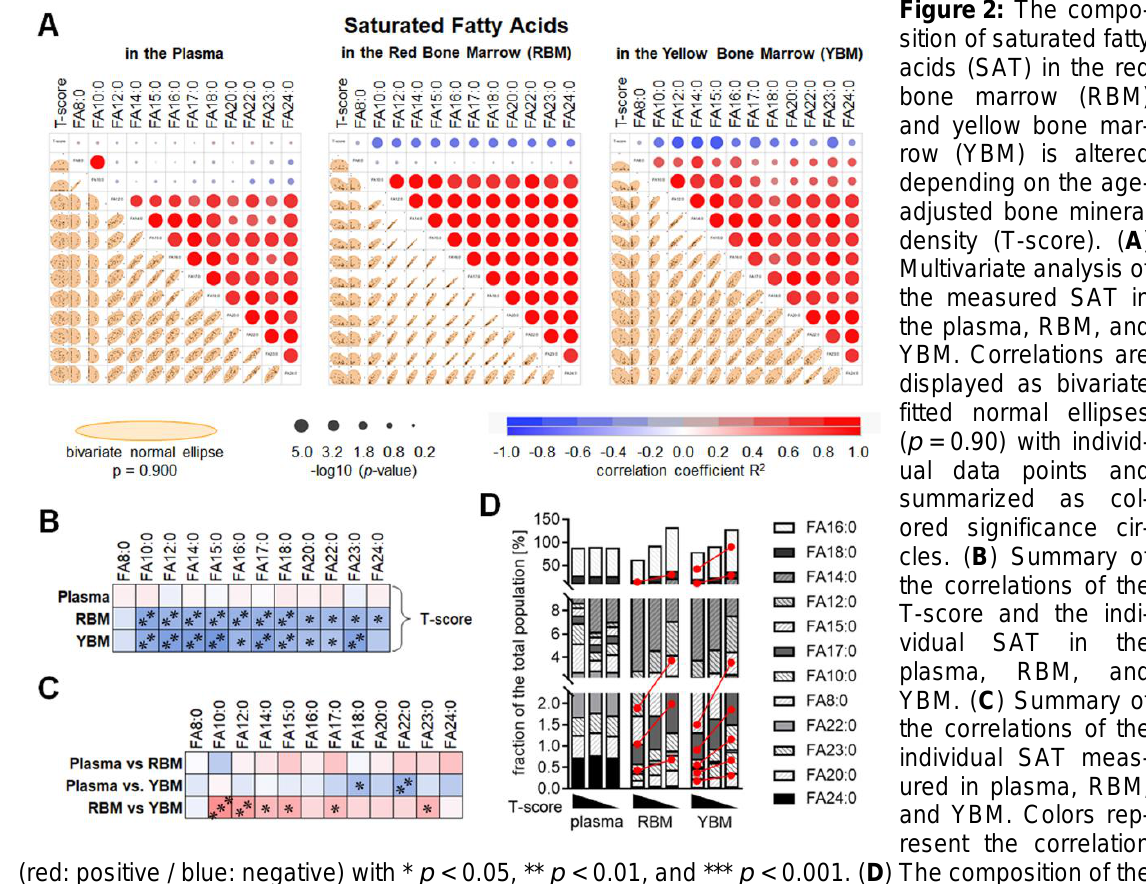
Figure 2: The compo- sition of saturated fatty acids (SAT) in the red bone marrow (RBM) and yellow bone mar- row (YBM) is altered depending on the age- adjusted bone mineral density (T-score). ( A ) Multivariate analysis of the measured SAT in the plasma, RBM, and YBM. Correlations are displayed as bivariate fitted normal ellipses ( p = 0.90) with individ- ual data points and summarized as col- ored significance cir- cles. ( B ) Summary of the correlations of the T-score and the indi- vidual SAT in the plasma, RBM, and YBM. ( C ) Summary of the correlations of the individual SAT meas- ured in plasma, RBM, and YBM. Colors rep- resent the correlation